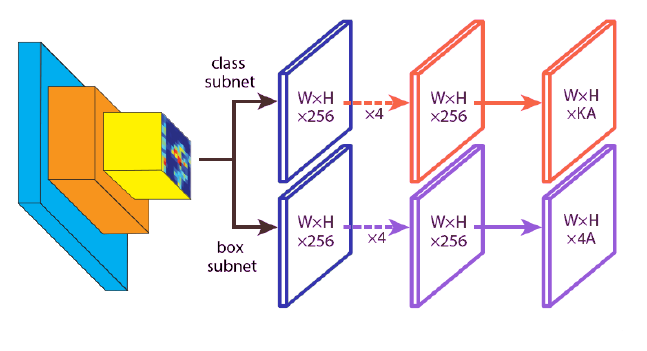
Figure 3. RetinaNet FCN subnetwork illustration: (top) classification subnet and (bottom) bounding box regression